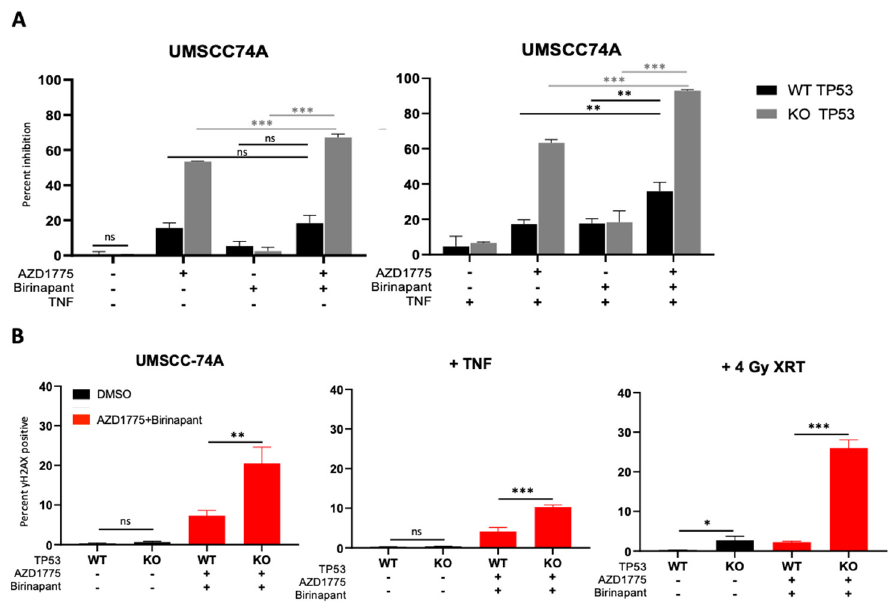
Figure 5. TP53 deficient HNSCC cells are more susceptible to combination therapy cytotoxicity and DNA damage. ( A ) XTT viability analysis in UMSCC74A TP53 WT and KO at 72 h normalized to DMSO control. AZD1775/Birinapant = 500 nM, TNF = 20 ng/mL. n = 3. ( B ) DNA damage according to γ‐ H2AX positivity on flow cytometry using CRISPR ‐ Cas9 UMSCC ‐ 74A p53 KO and parental UMSCC ‐ 74A WT. 1 h pre ‐ treatment with drugs before 4 Gy radiation then analysis 24 h post treatment. AZD1775/Birinapant = 500 nM, TNF = 20 ng/mL. n = 3. ns = not significant; * p < 0.05; ** p < 0.01; *** p < 0.001.